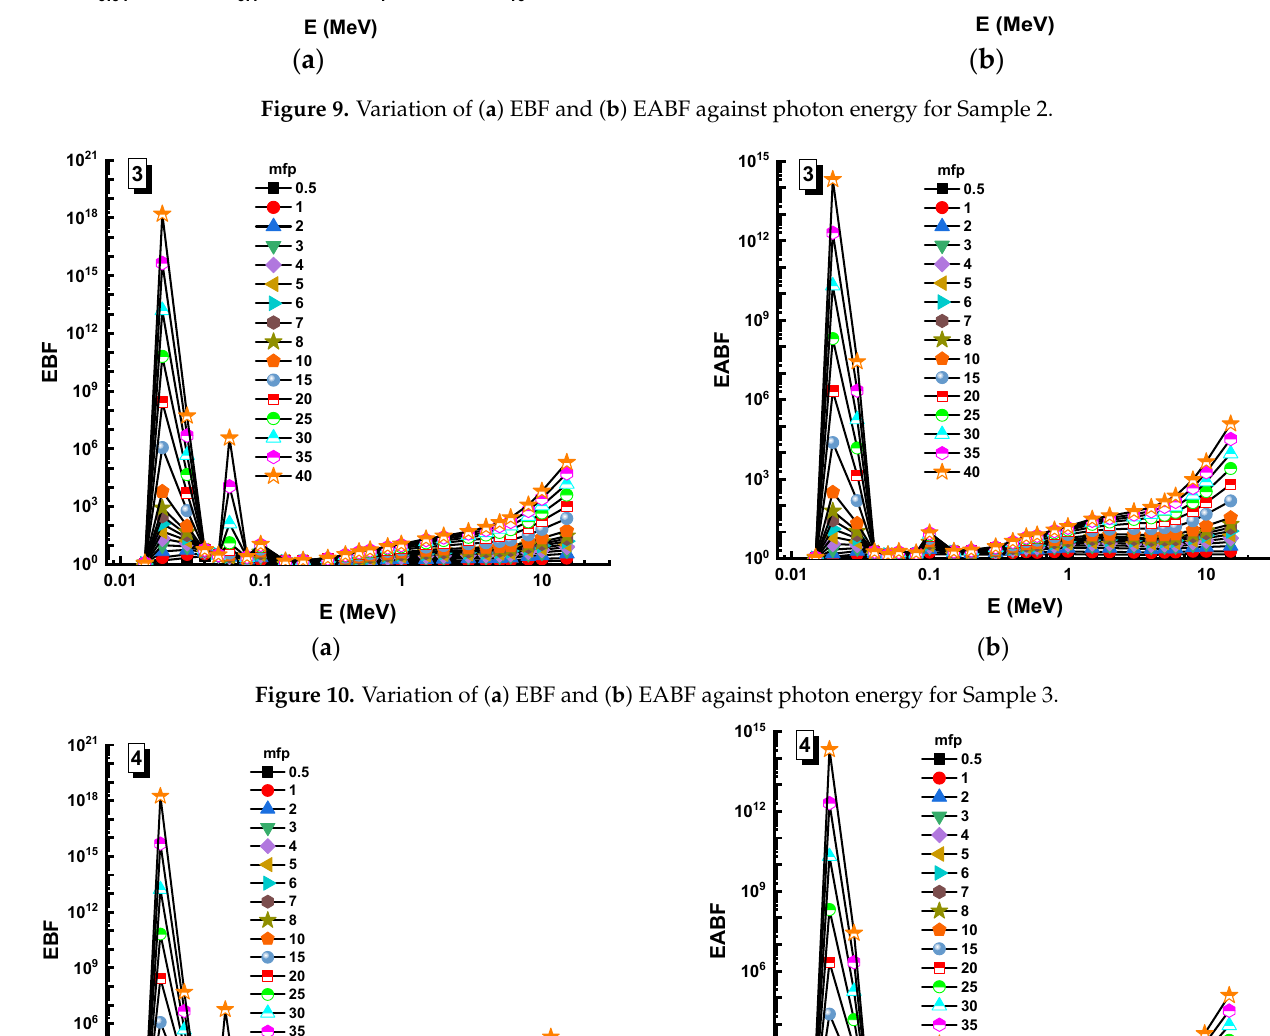
Figure 11. Variation of ( a ) EBF and ( b ) EABF against photon energy for Sample 4.